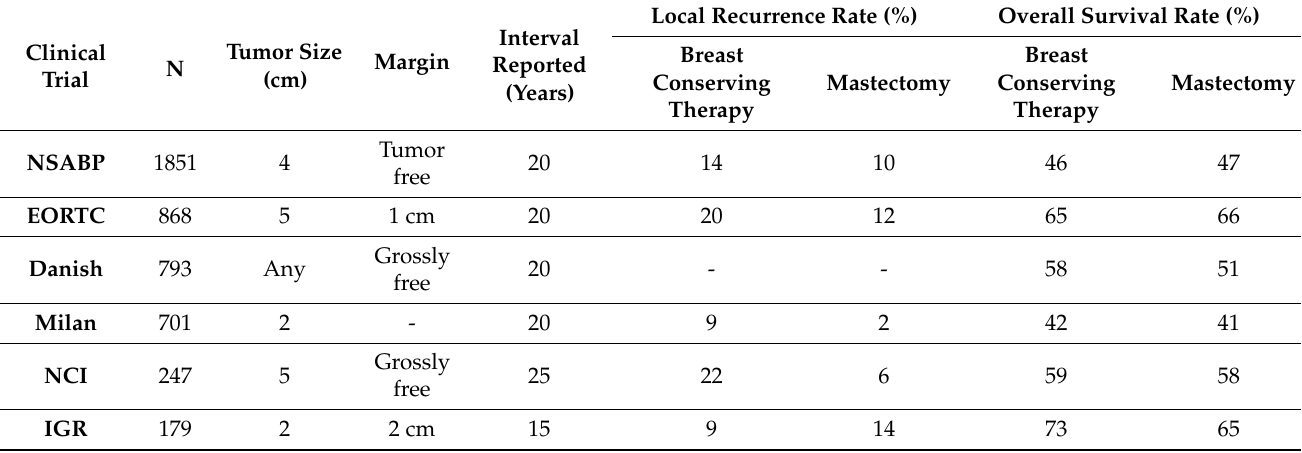
Table 2. Summary of prospective randomized clinical trials comparing breast conserving therapy with